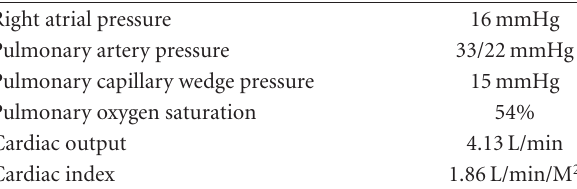
Table 1: Right heart